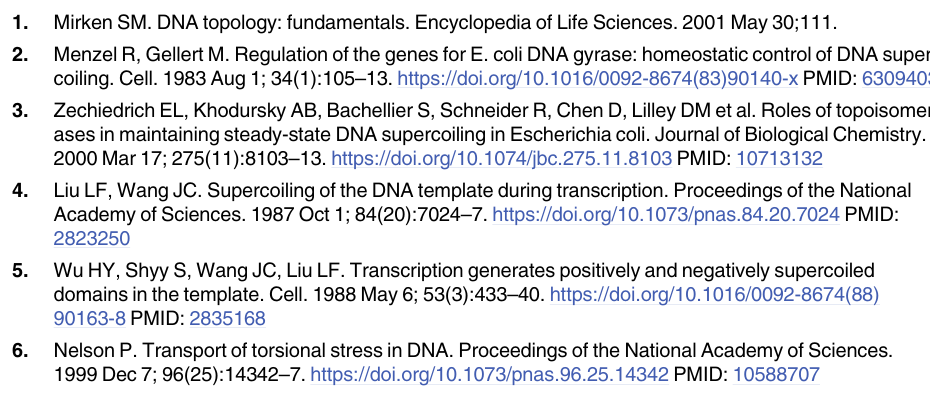
S2 Table. Model equations. S3 Table. Parameter estimation. S4 Table. Empirical initiation rate, elongation rate and RNAP density under different pro- moter